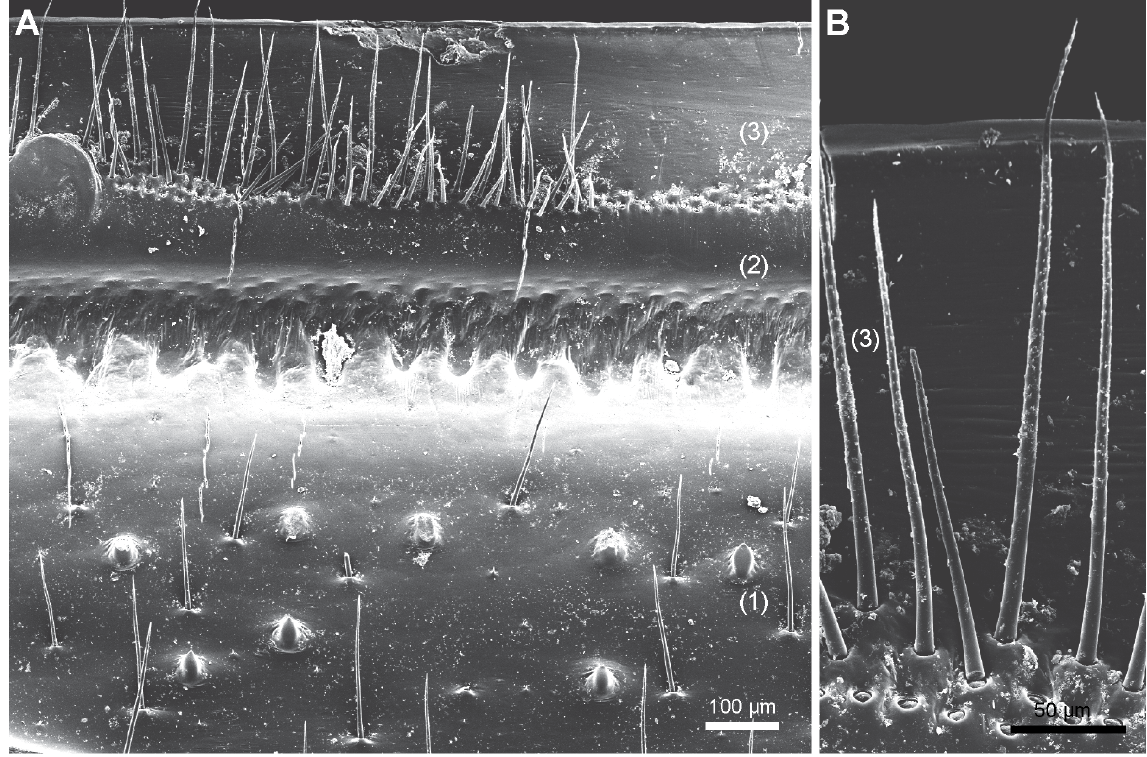
Fig. 4. Sphaeromimus kalambatritra sp. nov., SEM of endotergum, ♂, holotype ( CASENT 9068297- A). A . Overview, endotergum. B . Margin of endotergum, detail. Abbreviations: (1) = inner part; (2) = middle part; (3) = outer